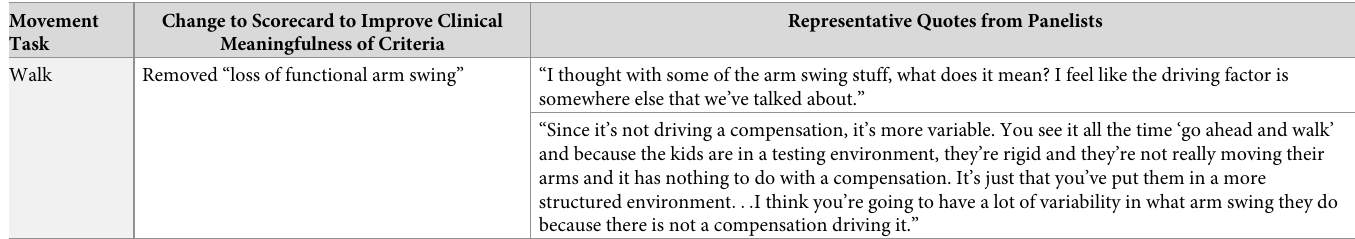
Table 4. Representative example of removal of compensatory movement criteria to ensure clinical meaningfulness during Round 2. Movement